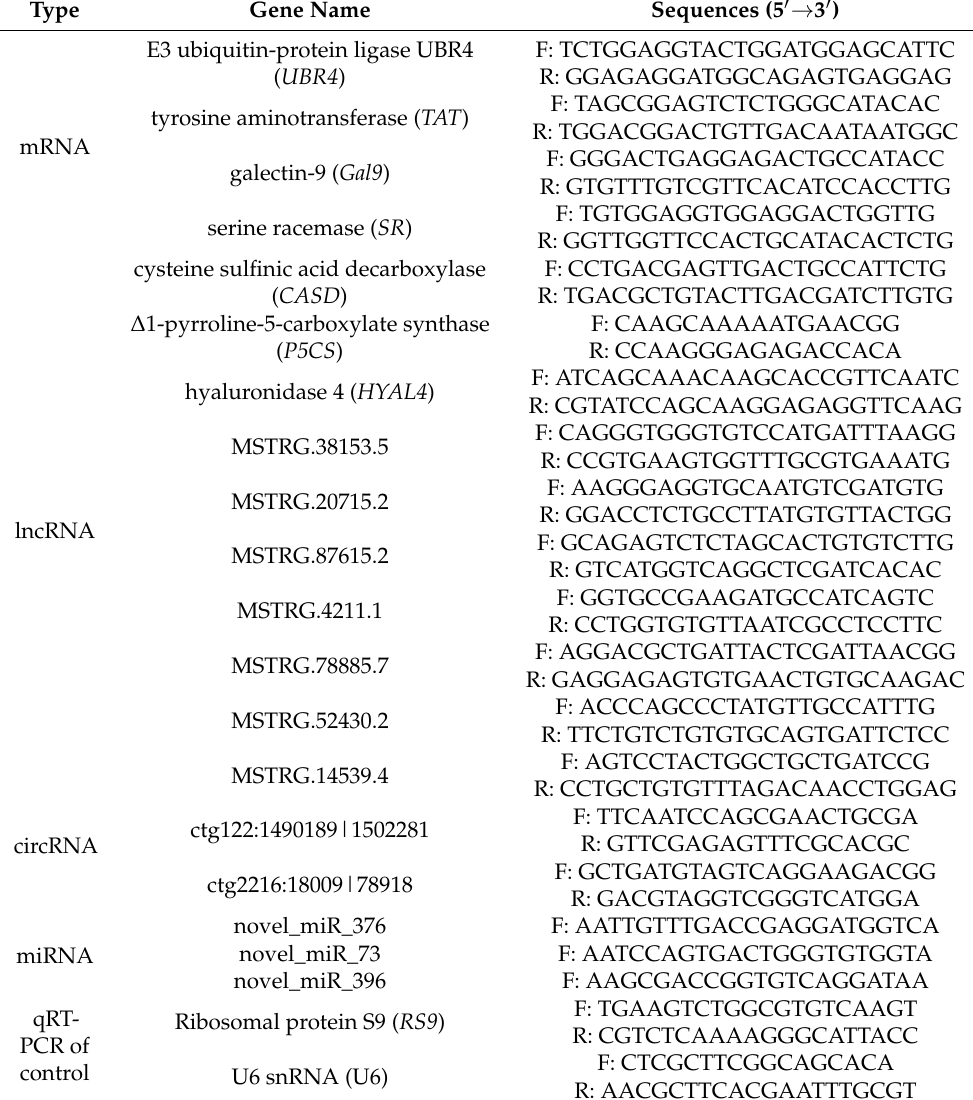
Table 1. Primers used for the qRT-PCR